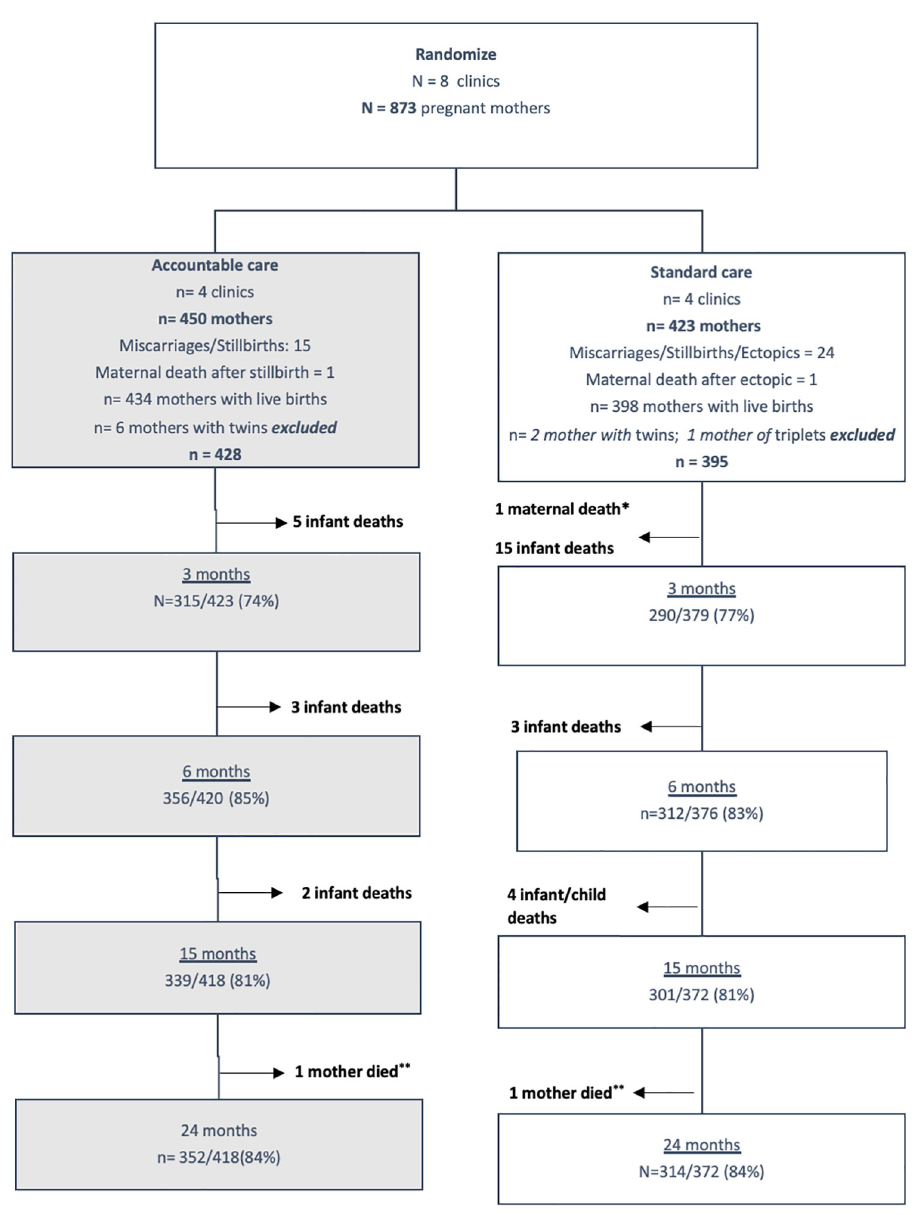
Fig 1. The flow of participants throughout the course of the trial. � Baby also died soon after birth, �� Though mother died, follow up of child with caregiver was still performed, therefore denominator was not affected.